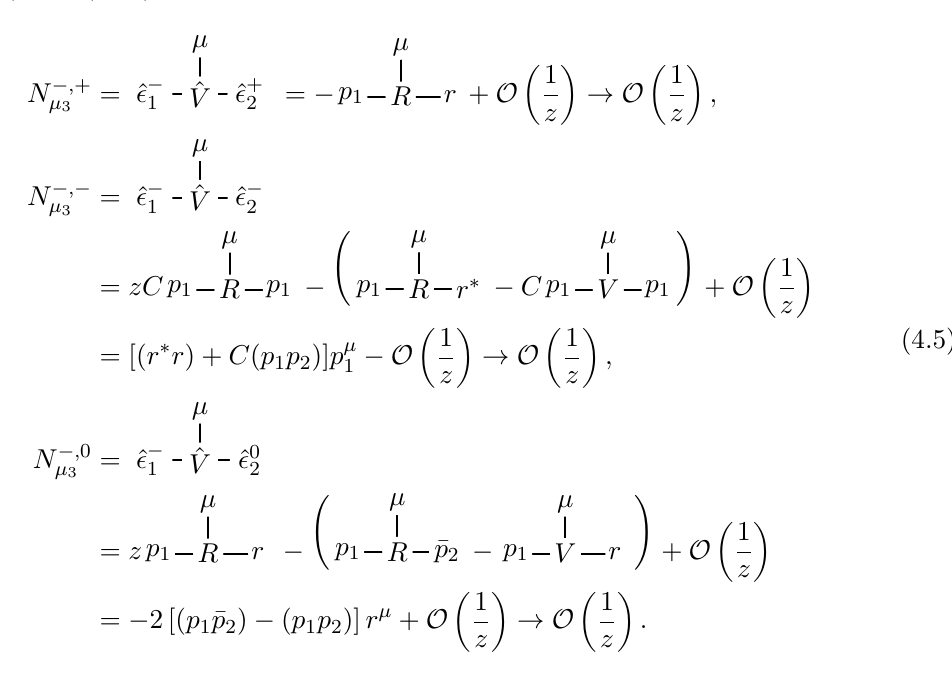
Figure 4 . The diagrams that give the leading contributions in the large- z limit. The blobs correspond to soft